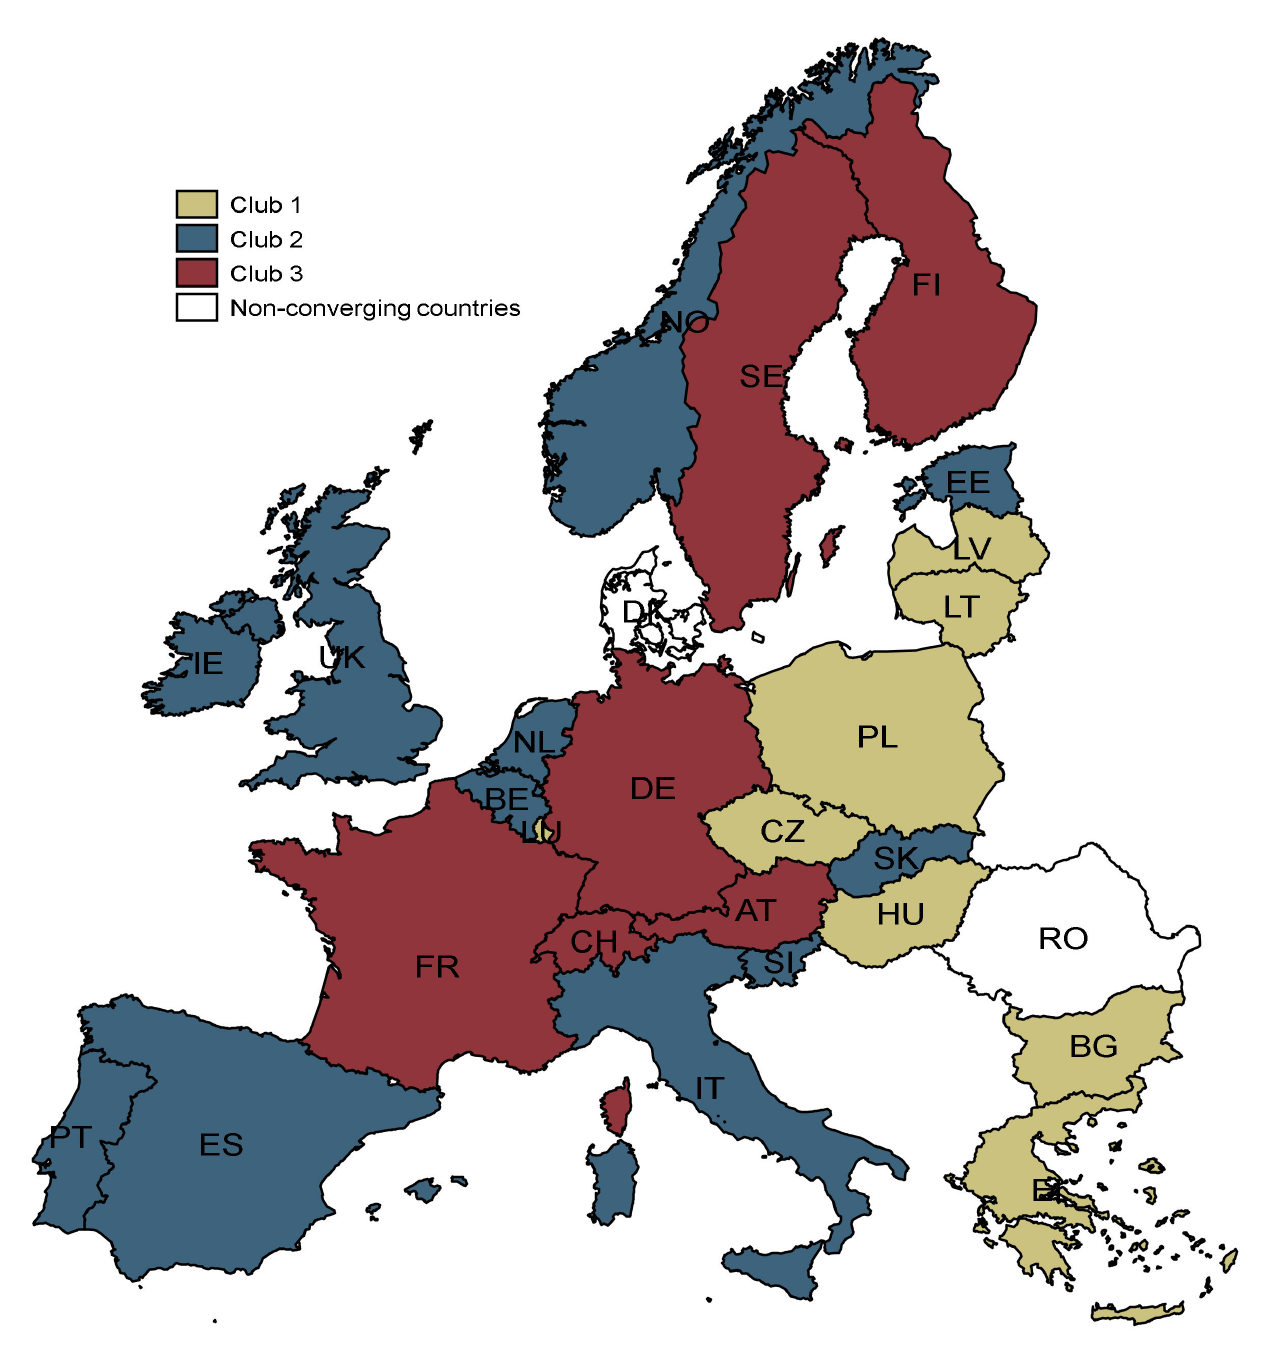
Figure 1. Spatial distribution of club